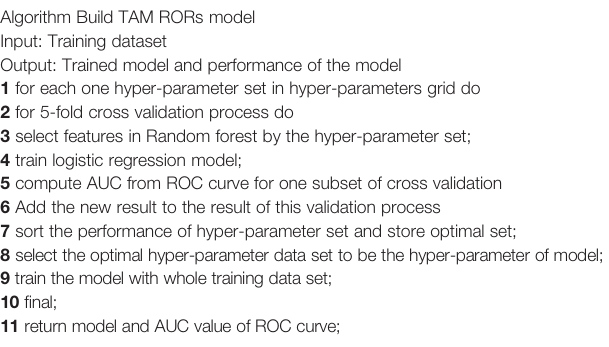
TABLE 3 | The process of building TAM RORs model. Algorithm Build TAM RORs model Input: Training dataset